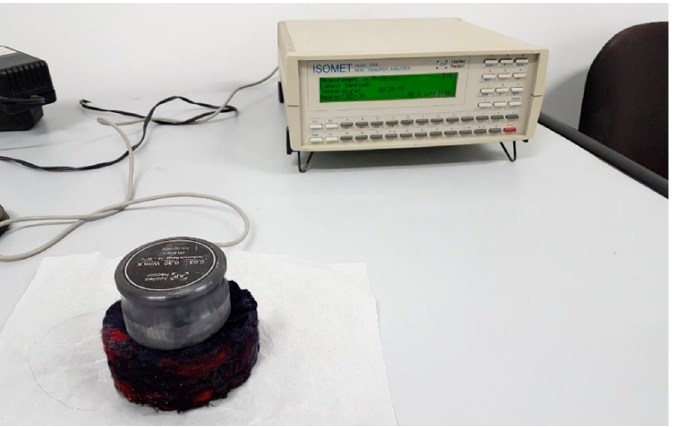
Figure 7. Measurement of thermal properties of PCM_00 specimen.